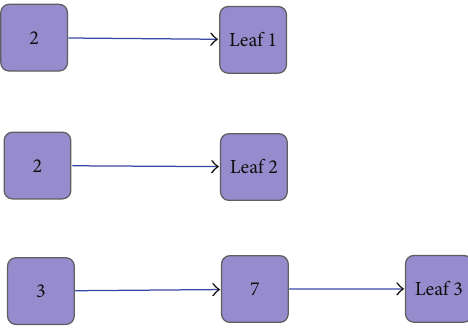
Figure 3: The adjacency list corresponding to Figure 1.